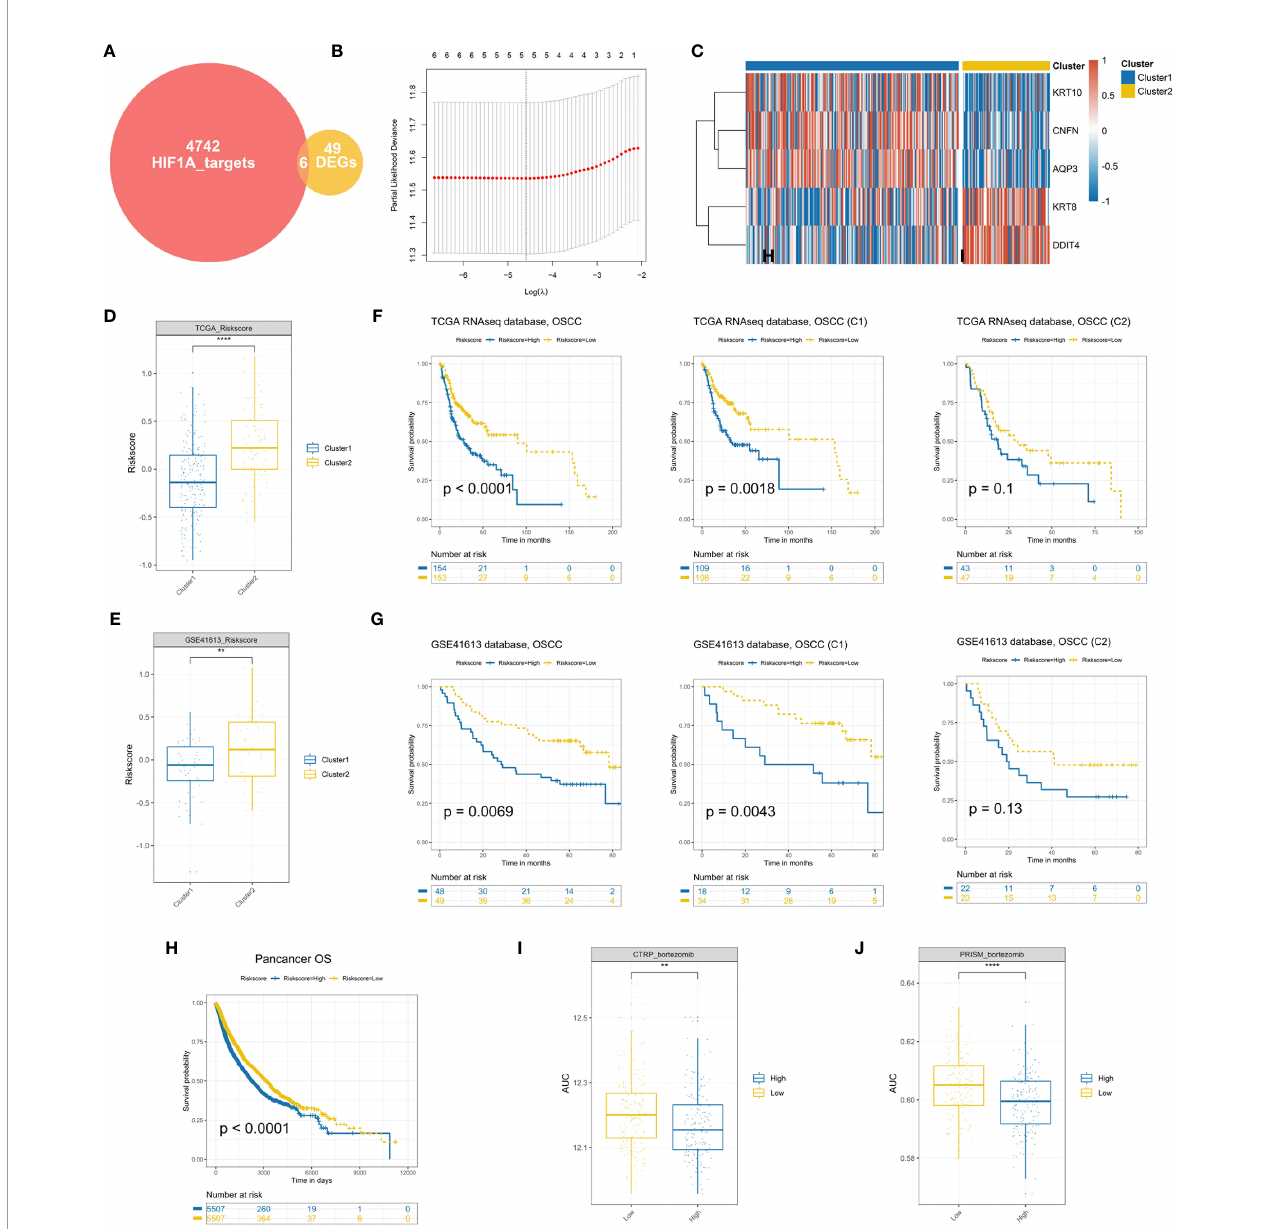
FIGURE 6 | Establishment and validation of a hypoxia prognostic signature (A) . A total of six candidate genes were identi fi ed in the intersection of “ HIF1A targets ” and “ DEGs. ” (B) Cross-validation for tuning parameter selection in the proportional hazards model. (C) Differential expression of genes in hypoxia signature. (D, E) Cluster 2 patients conferred a signi fi cantly higher hypoxia risk scores in the TCGA and GSE41613 cohorts. (F, G) Survival analysis of the hypoxia-associated signature in OSCC or OSCC subtypes. (H) The prognostic signi fi cance of the established signature across 33 cancer types. (I, J) The predicted AUC values of bortezomib from the CTRP and PRISM datasets were decreased in the high-risk score OSCC patients (** P < 0.01, **** P <